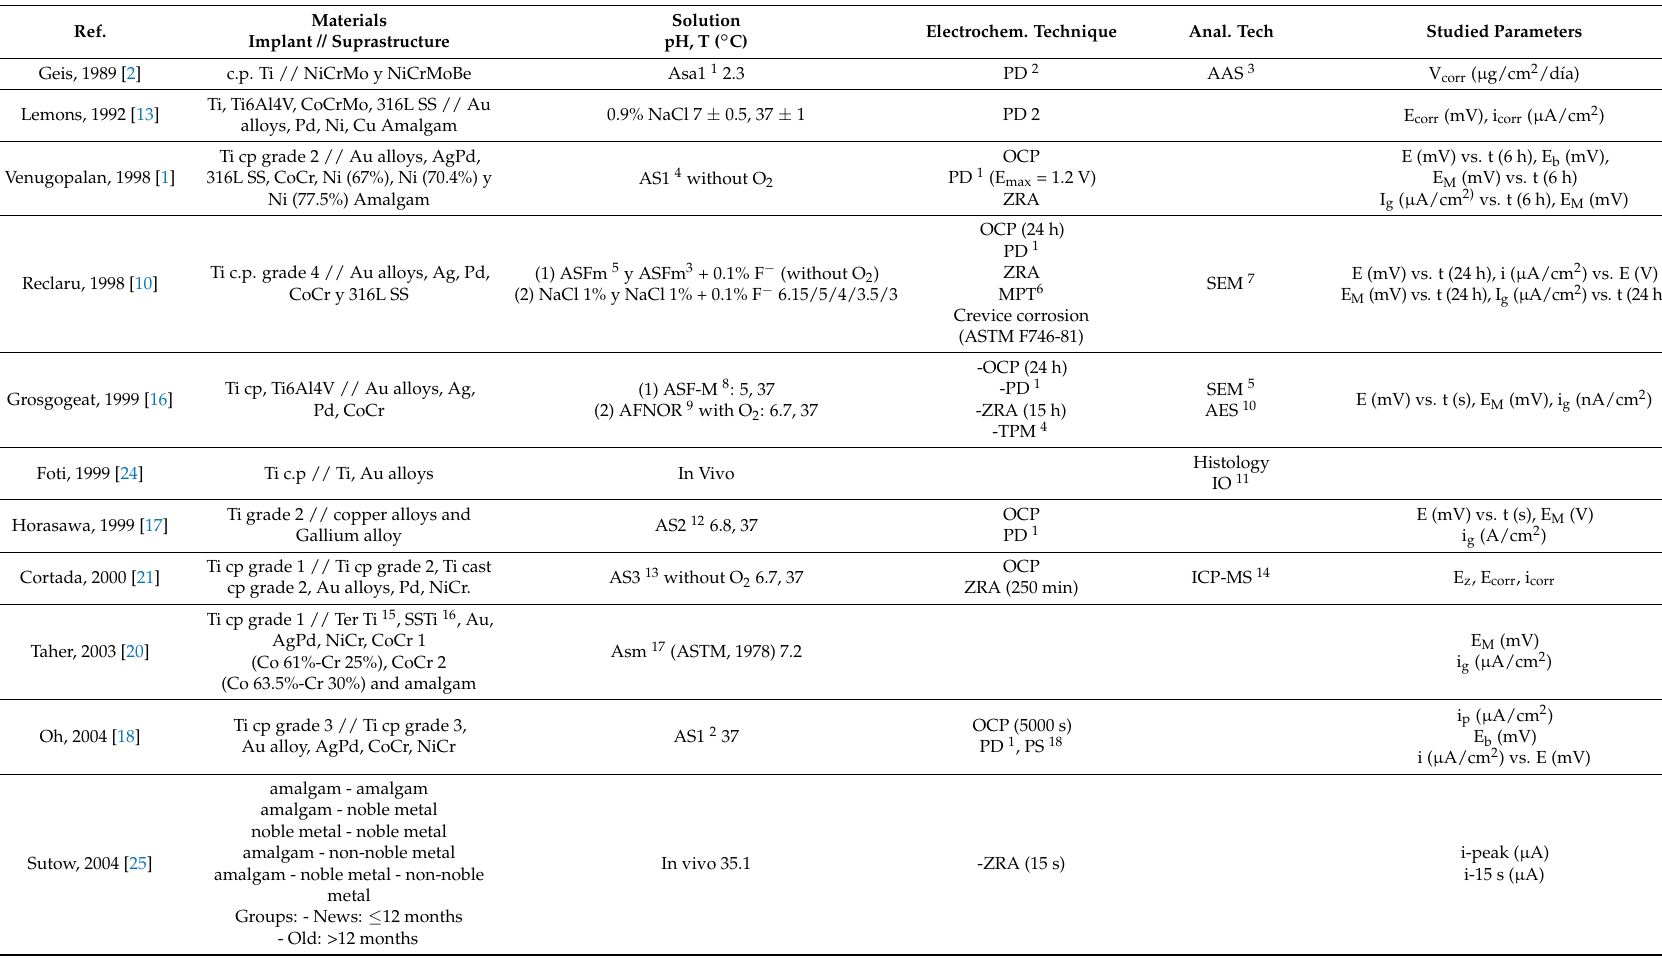
Table 1. Literature search about the existing knowledge on the galvanic corrosion mechanism in oral environment.